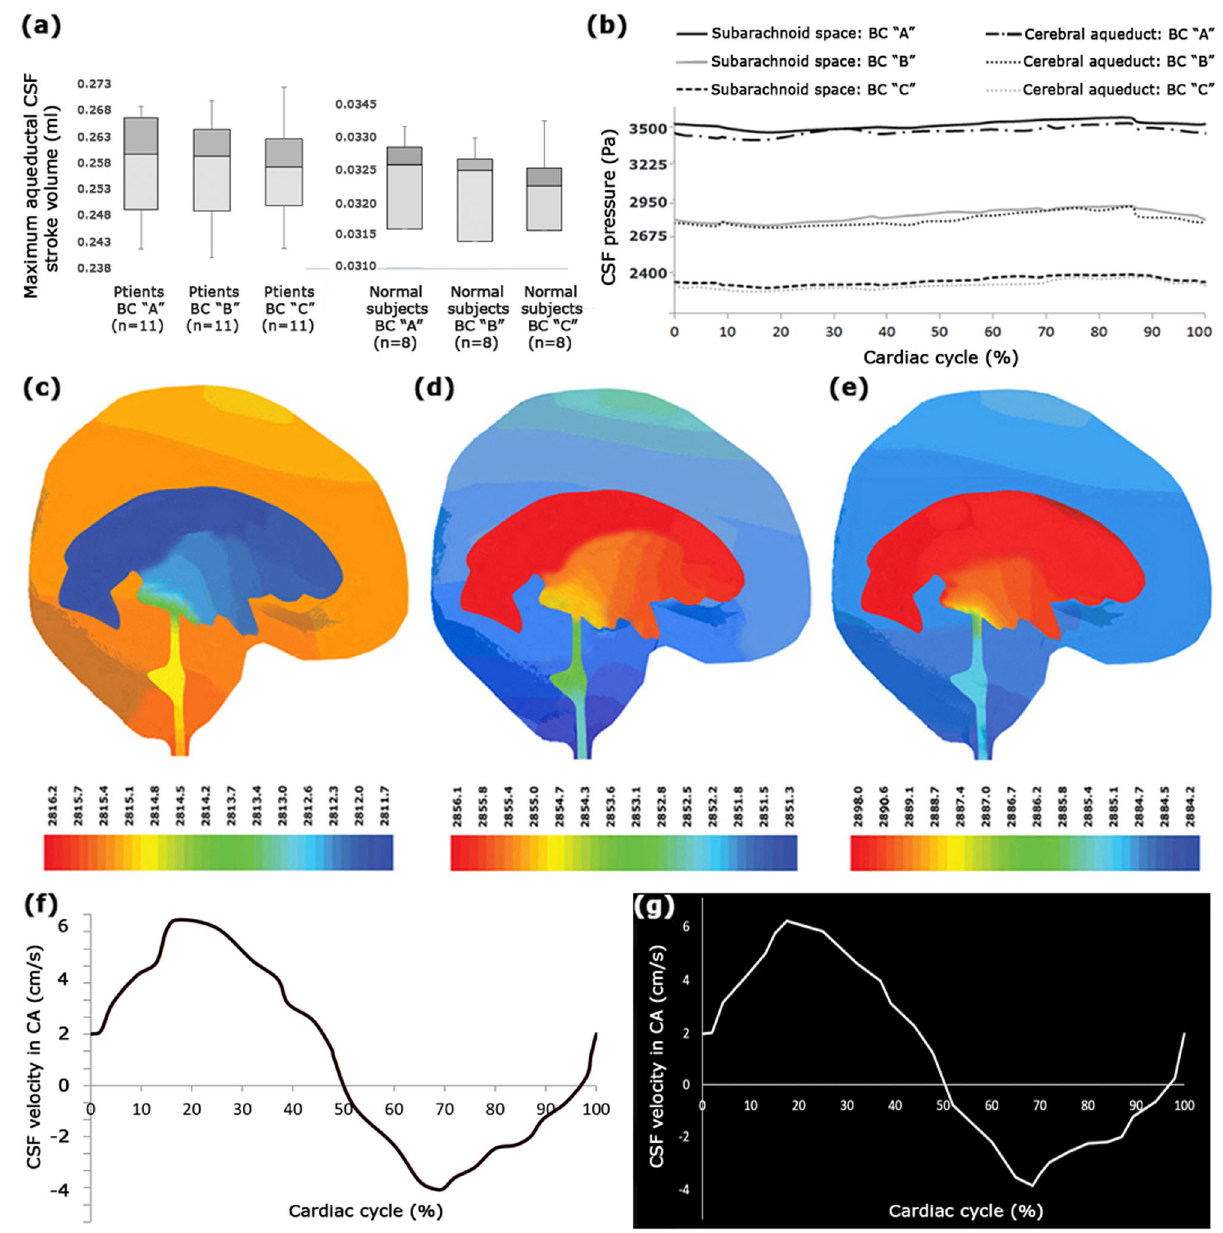
Fig. 1 Maximum aqueductal stroke volume, pressure, and velocity of CSF fl ow. a The values of the maximum aqueductal CSF stroke volume for healthy subjects and patients under BCs “ A ” , “ B ” , and “ C ” . It should be noted that there were 8 healthy subjects and 11 hydrocephalus patients in this study. b compares the CSF pressure diagrams in the SAS and CA of patient No. 7 under BCs “ A ” , “ B ” , and “ C ” . c – e display three snapshots of CSF pressure distribution under BC “ B ” in the patient No. 7 at 17.5% (mid-systole), 64% (diastole), and 84% (early systole) of the cardiac cycle, respectively. The units of the color scale are Pascal. Panels ( f ) and ( g ), respectively, show the CSF velocity diagram calculated with FSI simulation and the in vivo-measured diagram based on the cardiac cycle under BC “ C ” in the CA of patient No. 7. Raw data for Fig. 1a are included in Supplementary Data 1. CV coef fi cient of variation, SE standard error, BC boundary condition, CSF cerebrospinal fl uid, CA cerebral